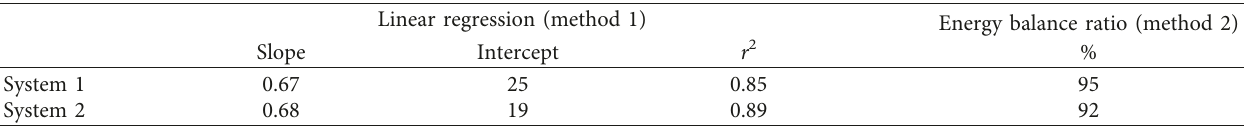
Table 1: Energy balance closure. Method 1: linear regression between R each system sum of H + LE divided by R N − B S .